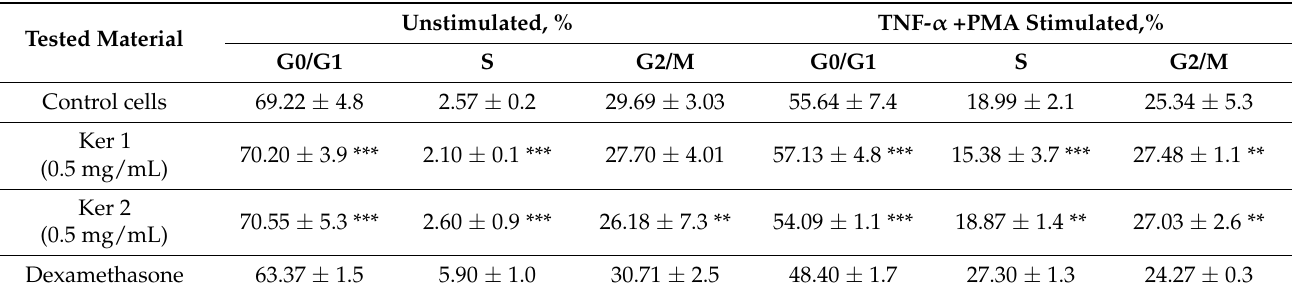
Table 5. HS27 proliferative status expressed as cell cycle progression in normal and pro-inflammatory conditions.